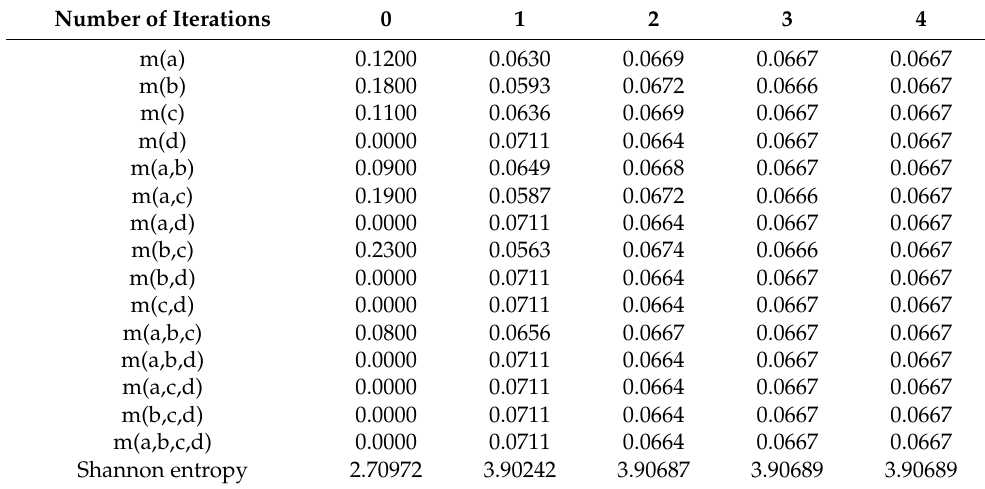
Table 4. BPA and entropy after logarithmic negation iterations in Example